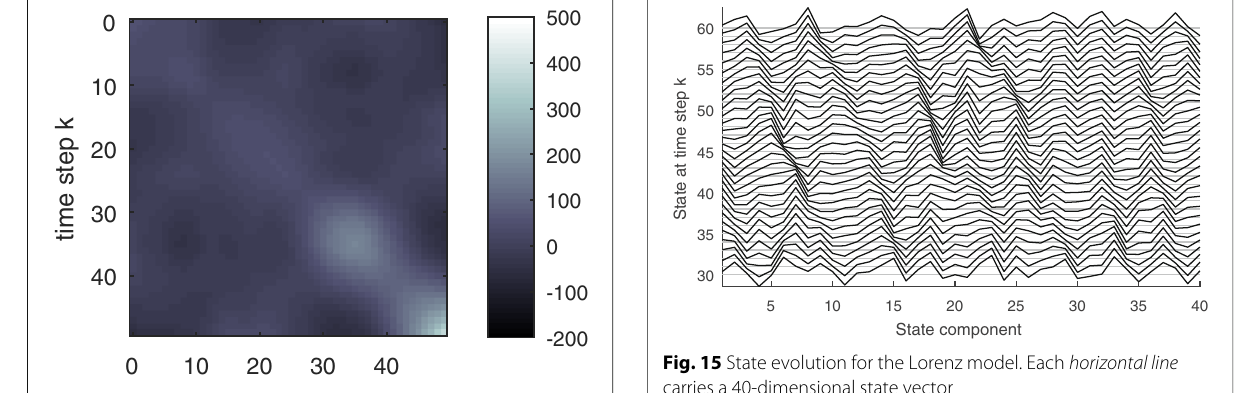
intervals T = 0.05 only and act as process noise. A Runge- Kutta method (RK4) is used to discretize (37) to obtain the nonlinear state difference Eq. (2a) with x k = x k and v k = F k . The step size T corresponds to about 6 h if x were an atmospheric quantity on a latitude circle of the earth [53]. Although the model (37) is said to be chaotic, the effects are only mild for short integration times T . In our experiments, all n = 40 states are measured with additive Gaussian noise e k ∼ N ( 0, I ) . The initial state is Gaussian with x 0 ∼ N ( 0, P 0 ) , where P 0 is drawn from a